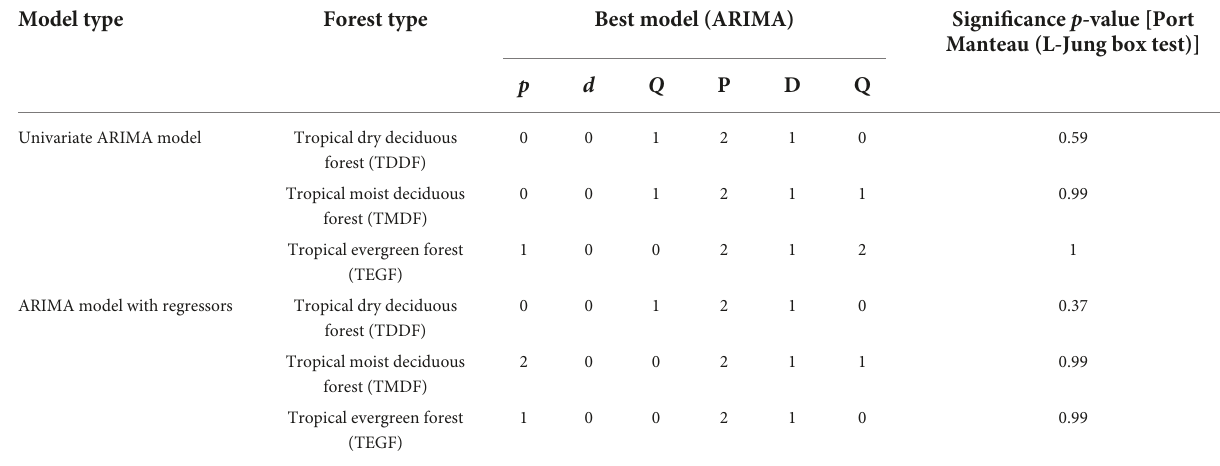
TABLE 1 Comparison of model results obtained through univariate ARIMA model and ARIMA model with